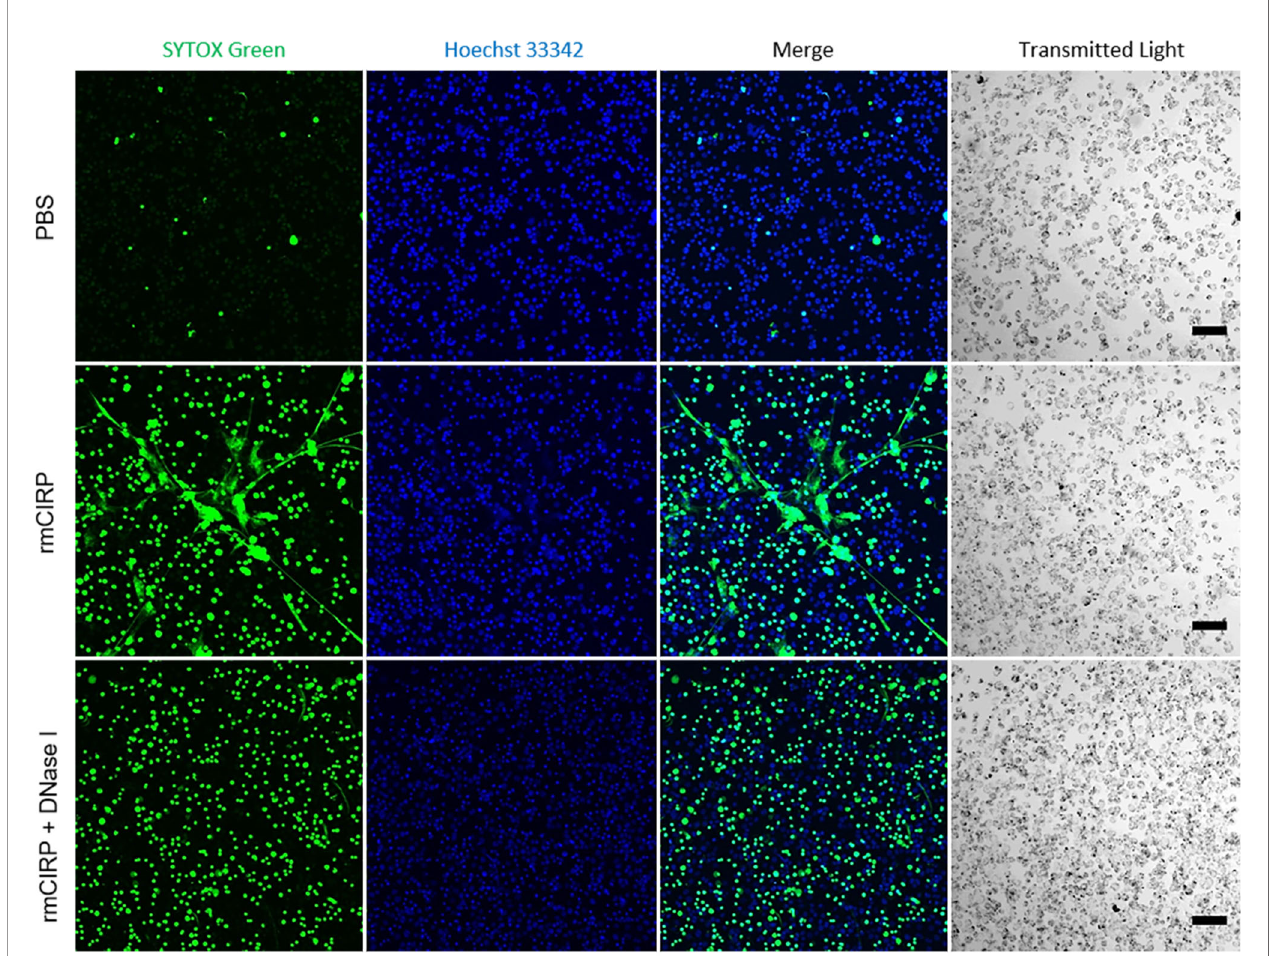
FIGURE 3 | eCIRP-induced METs are eliminated by DNase I treatment. THP-1 cells were treated with PBS (top panel), rmCIRP (1 µg/ml) (middle panel), or rmCIRP (µg/ml) and DNase I together (bottom panel) and incubated for 6 h and followed by the incubation of Hoechst 33342 and SYTOX Green stain for 1 h. The images were taken with a Zeiss LSM880 confocal microscope equipped with EC Plan-Neo fl uar 10×/0.30 M27 objective lens. While control cells did not show any MET formation by treatment of the buffer solution alone, rmCIRP treatment induced a massive network of extracellular traps in the culture. However, co-treatment of rmCIRP and DNase I (10 U/ml) eliminated the extracellular traps in the culture with a similar number of SYTOX Green positive cells, comparable to the number of rmCIRP alone treated. The acquired z-stack scan images were then processed to make maximum intensity projection by Fiji ImageJ. Scale bar, 100